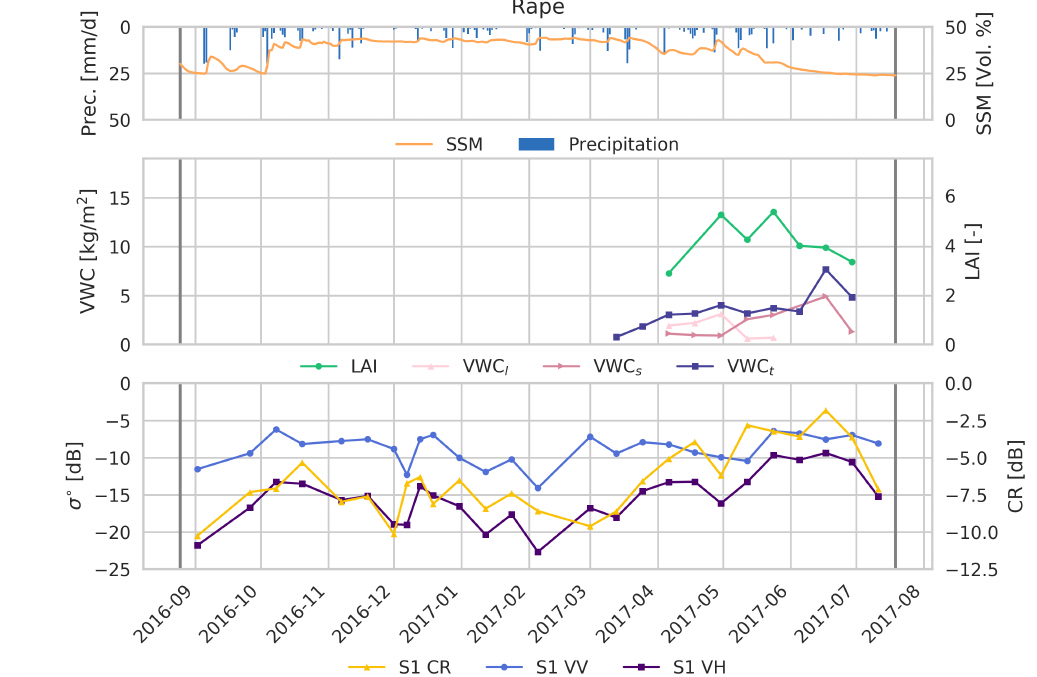
Figure 3. Time series of Sentinel-1 and in situ variables as in Figure 2 for